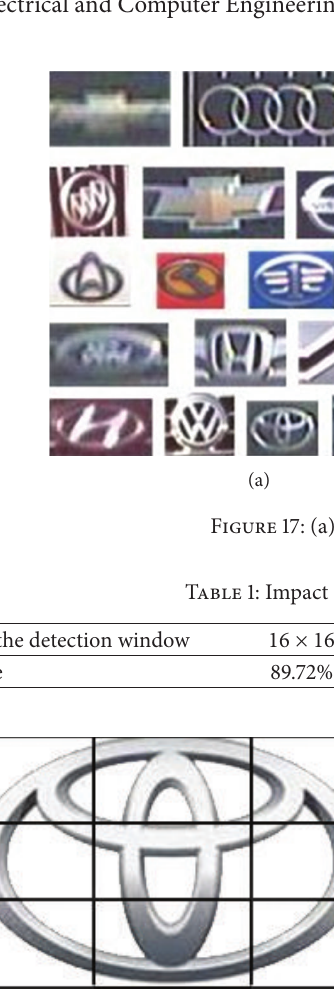
Figure 18: 3 × 3 blocks of cells overlaid a logo image for calculating HOG